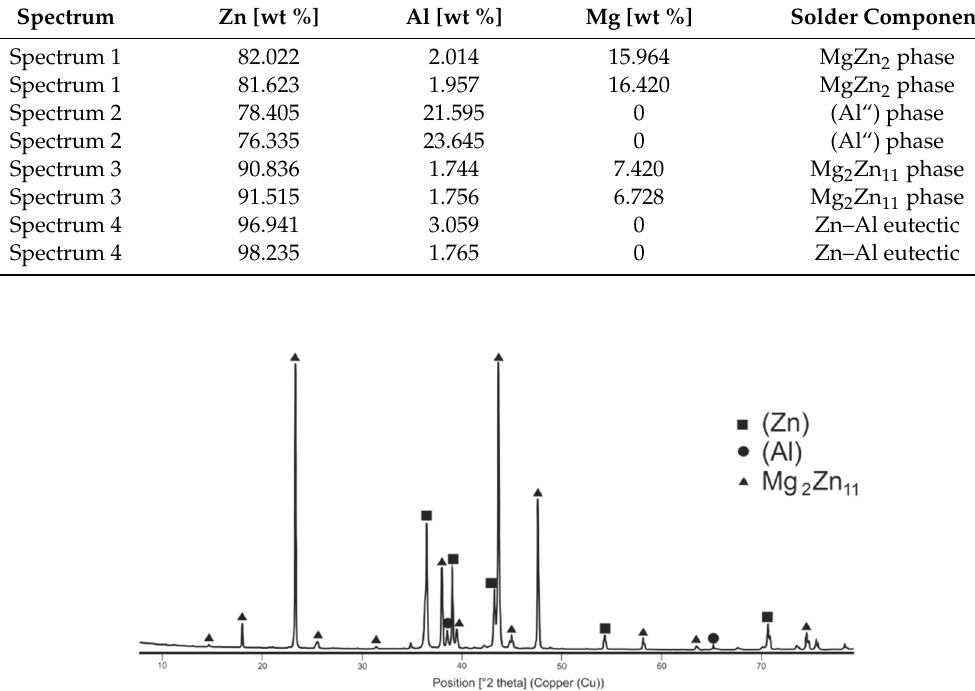
Figure 11. The diffraction record of Zn5Al3Mg solder.